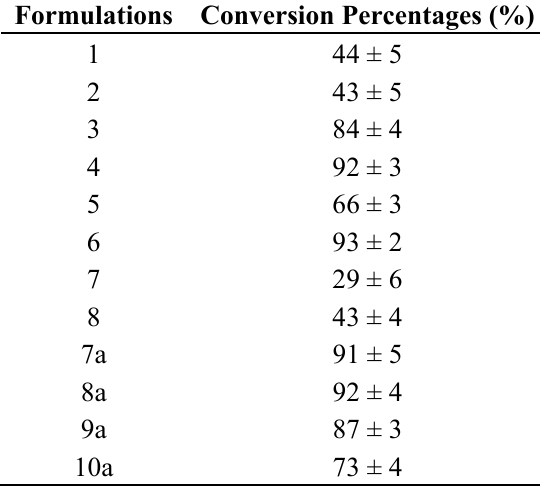
Table 5. Conversion percentages obtained for the UV water-based